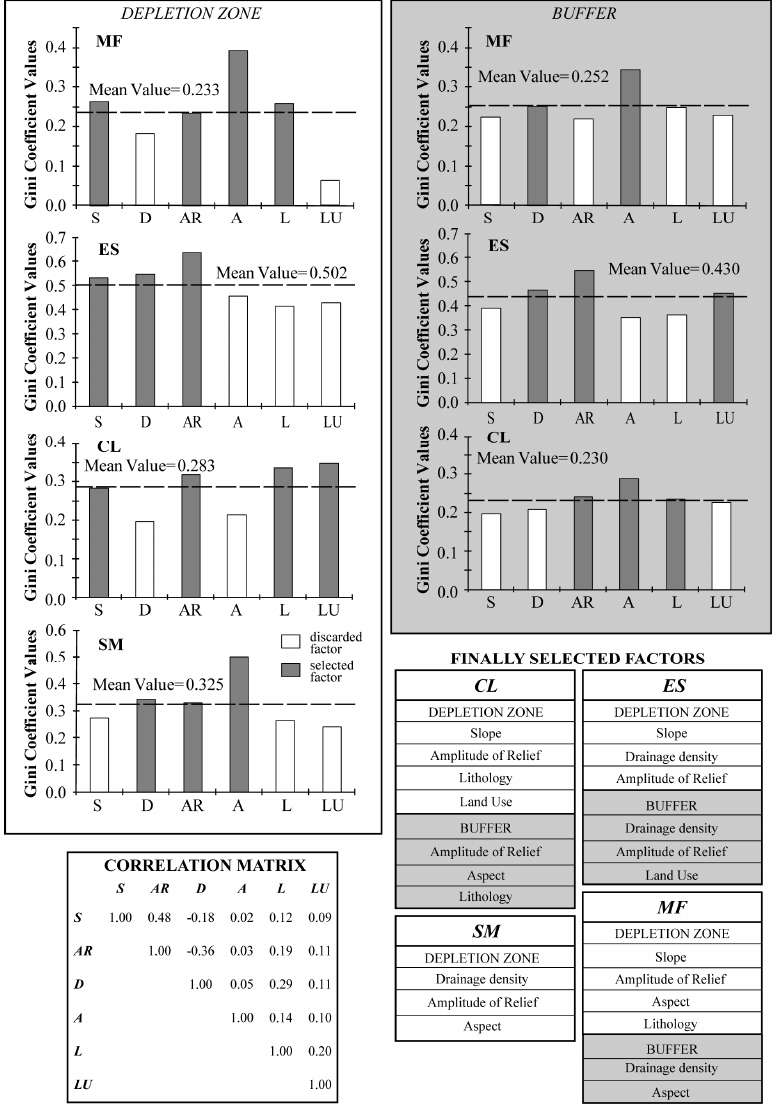
Figure 8: Histograms of the Gini coefficient value distribution for each landslide type obtained after the spatial intersection between each causal